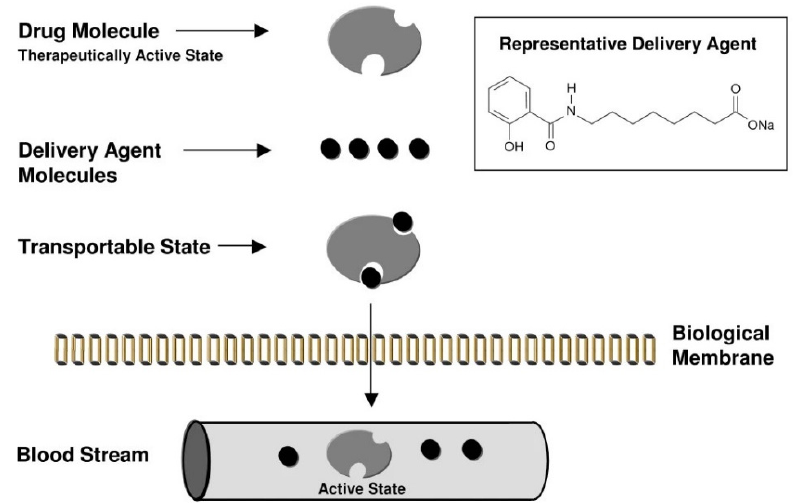
Figure 4. Schematic diagram of the mechanism of the Eligen™ technology (carrier mechanism). Emisphere researchers have argued that small carrier molecules with hydrophobic moieties increase lipophilicity through the formation of weak non-covalent bonds with drug molecules [120]. Through this journey, SNAC (N-[8-(2-hydroxybenzoyl)amino] caprylate) was devel- oped, which also led to the development of oral semaglutide and other leading compounds such as 5-CNAC (8-(N-2-hydroxy-5-chloro-benzoyl)-amino-caprylate) and 4-CNAB (N-(4- chlorosalicyloyl)-4-aminobutyrate) (Figure 5). The most advanced of these is SNAC, which has been applied in clinical trials with insulin [121], heparin [122,123], ibandronate [124], and peptide YY3-36 (PYY3-36) [125], and led to the successful development of oral vita- min B12 and semaglutide products. The remaining leading compounds are 5-CNAC and 4-CNAB. The compound 5-CNAC has been applied to salmon calcitonin and has moved to phase 3 clinical trials [126]. The compound 4-CNAB, for its part, has been applied to insulin, and phase 1 clinical trials have been completed